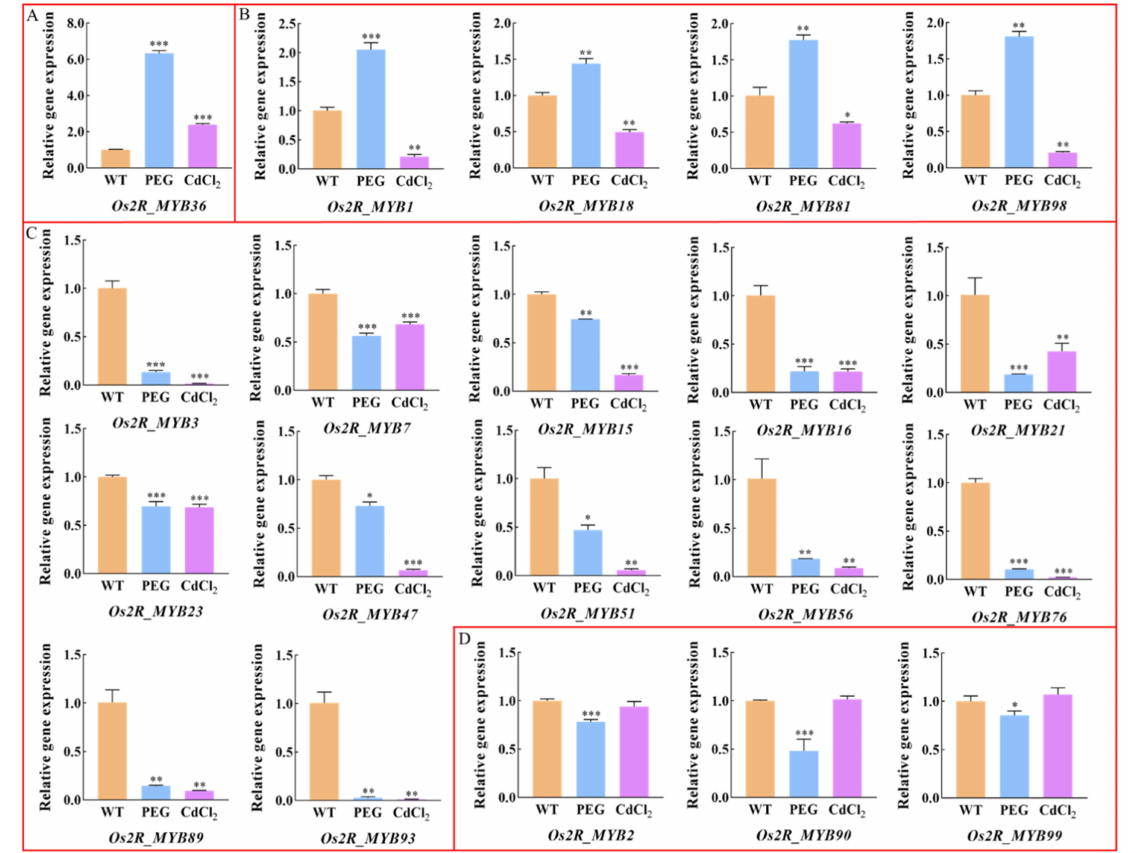
Figure 9. Relative gene expression of 20 Os2R_MYBs under PEG and CdCl 2 stress treatments. ( A – D ) represent different expression patterns under PEG and CdCl 2 stress treatment. Nipponbare cultivar was used as the control; OsActin1 was used as a reference gene. The relative expression levels of each gene were calculated by the 2 − ∆∆ Ct method. All reactions were set up in triplicate. Bars represent the standard deviation (SD) of the three replicates. A significant difference is indicated by an asterisk according to t -test (* p < 0.05, ** p < 0.01, and *** p <